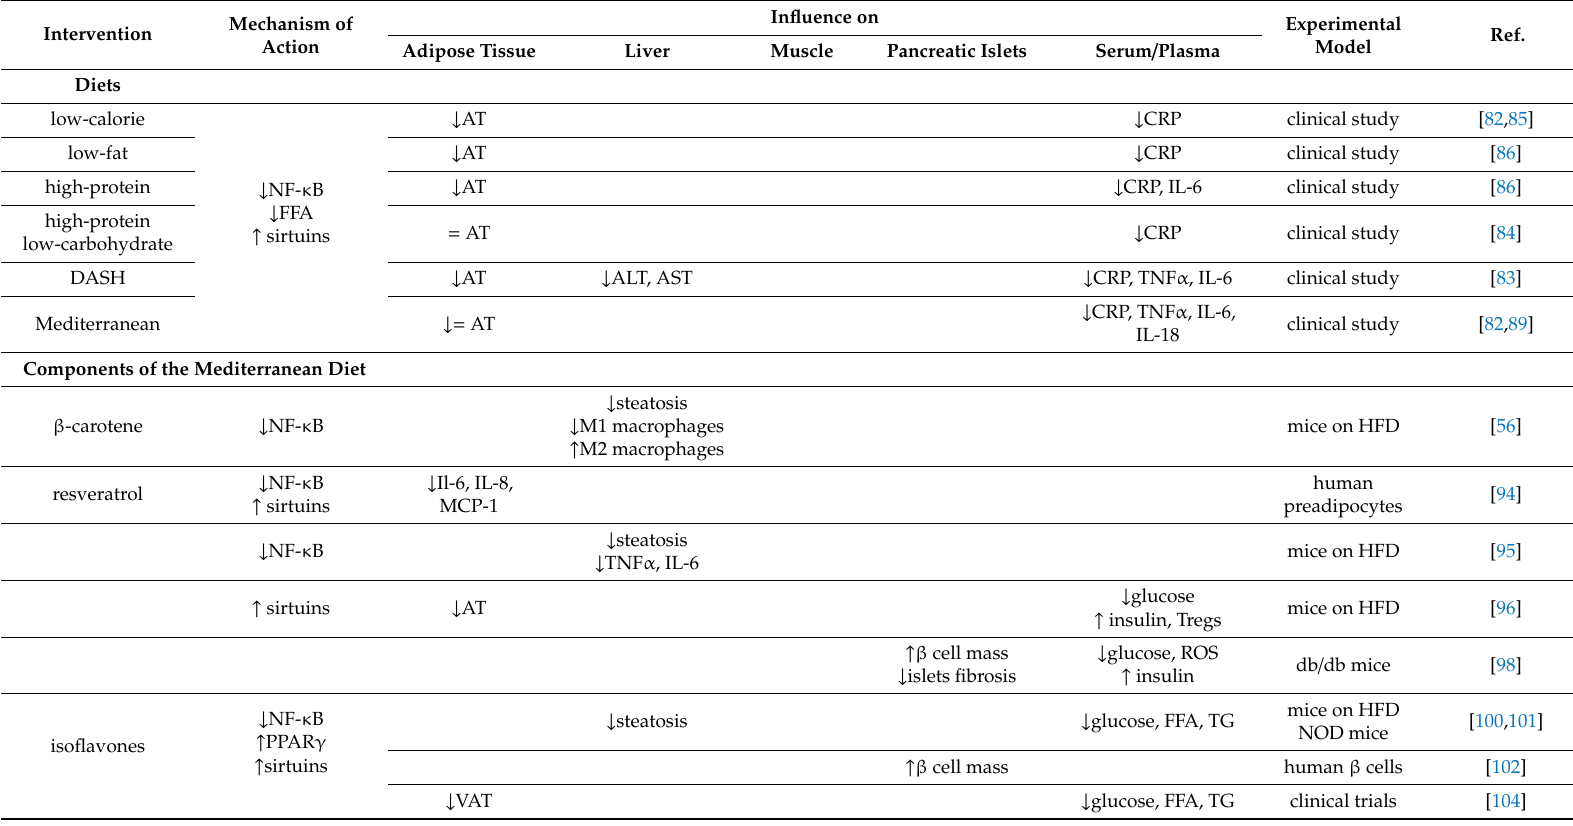
Table 1. Summary of the life-style interventions targeting metaflammation in type 2